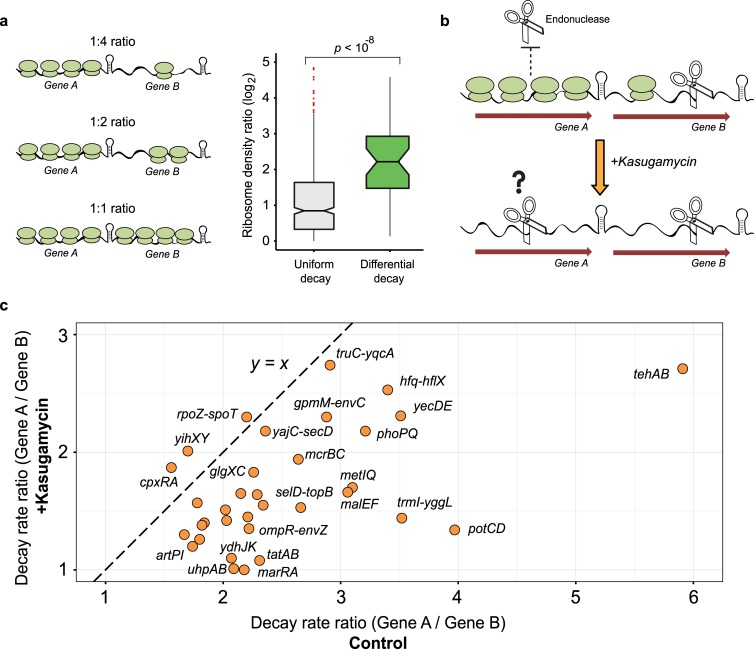
Ribosome density can guide differential operon decay.(A), Comparison of the relative ribosome densities across uniformly (n = 533) and differentially decaying operonic gene-pairs for which ribosome densities were previously measured (n = 39) [3] is shown as grey and green box-plots, respectively. Outliers are marked as red dots and the median is marked as a horizontal line within the box. The distributions were compared using a two-sided Wilcoxon rank-sum test (p < 10−8). On the left, a drawing illustrates the growing differences in ribosome densities between the genes along the boxplot’s y-axis. (B), Illustration of the effect of the translation-initiation inhibitor kasugamycin and its hypothesized effect on ribosome densities in polycistronic transcripts. (C), A scatter plot showing the change in relative decay rate of regulated gene-pairs calculated using recently published decay rates [22] for control (x-axis) and kasugamycin treated (y-axis) bacteria (S8 Table). The y = x function (denoting 1:1 ratio) is shown as a dashed line.